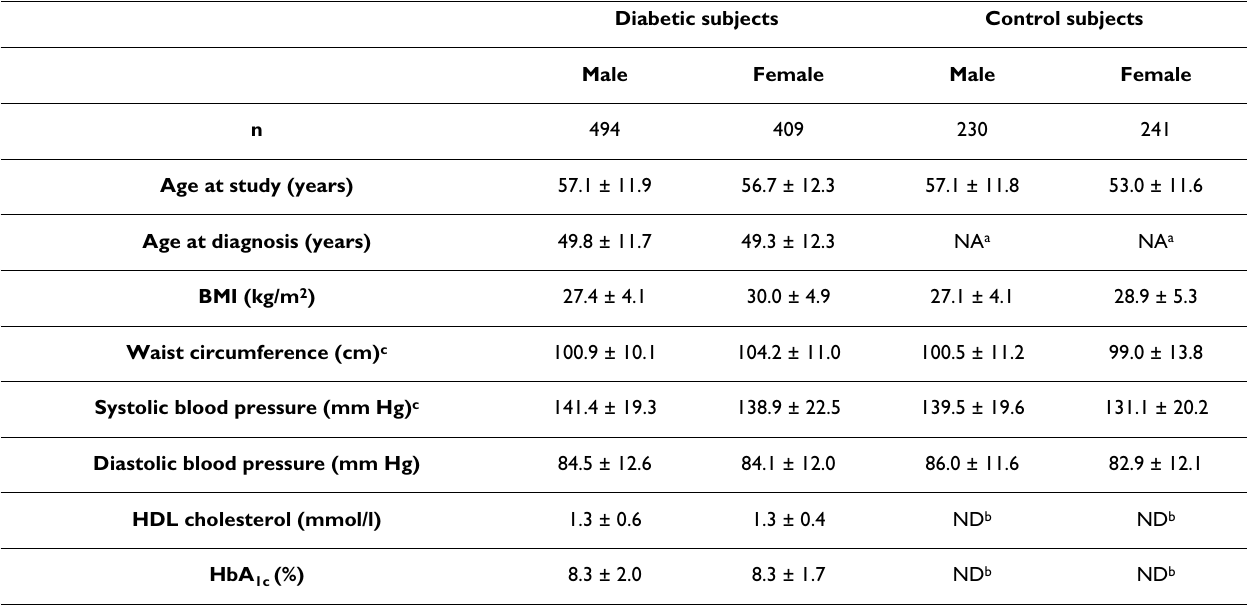
Table 1: Clinical characteristics of subjects